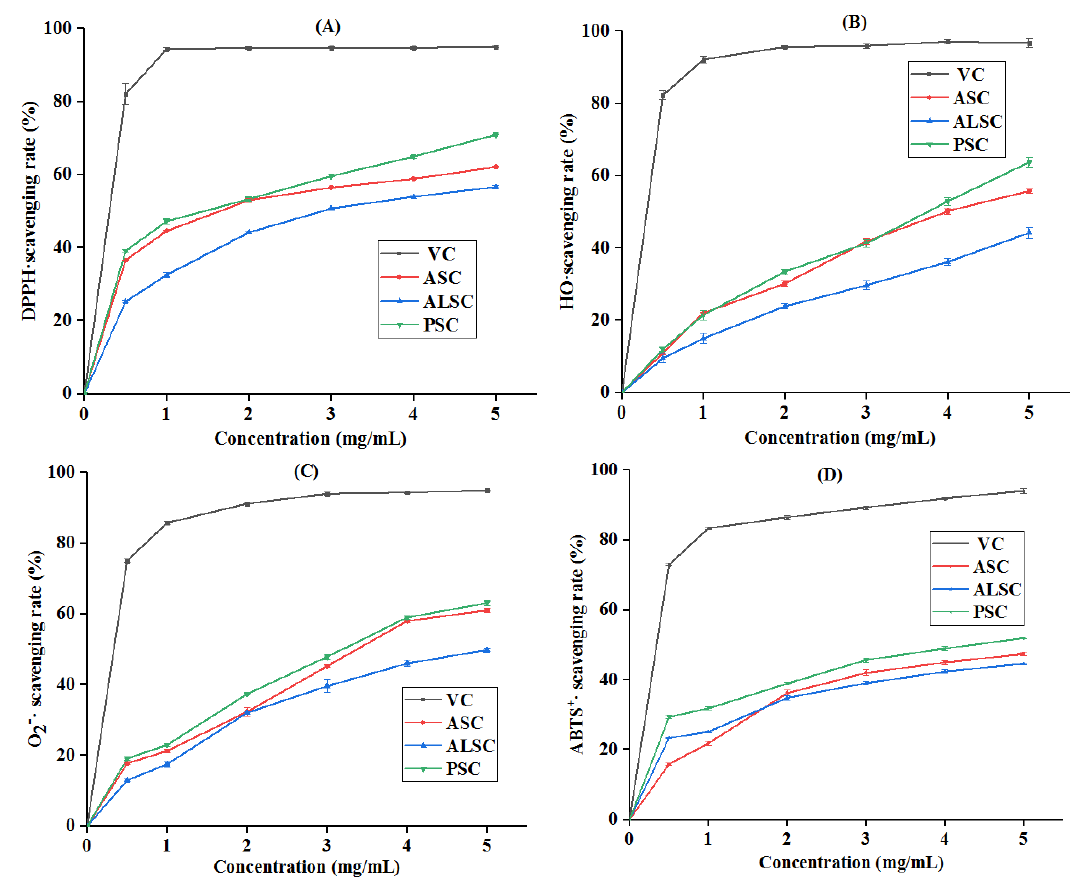
Figure 6. DPPH• ( A ) , HO• ( B ), O 2 − • ( C ), and ABTS + • ( D ) scavenging activities of ASC, ALSC, and Figure 6. DPPH • ( A ), HO • ( B ), O 2 − • ( C ), and ABTS + • ( D ) scavenging activities of ASC, ALSC, PSC. and PSC.